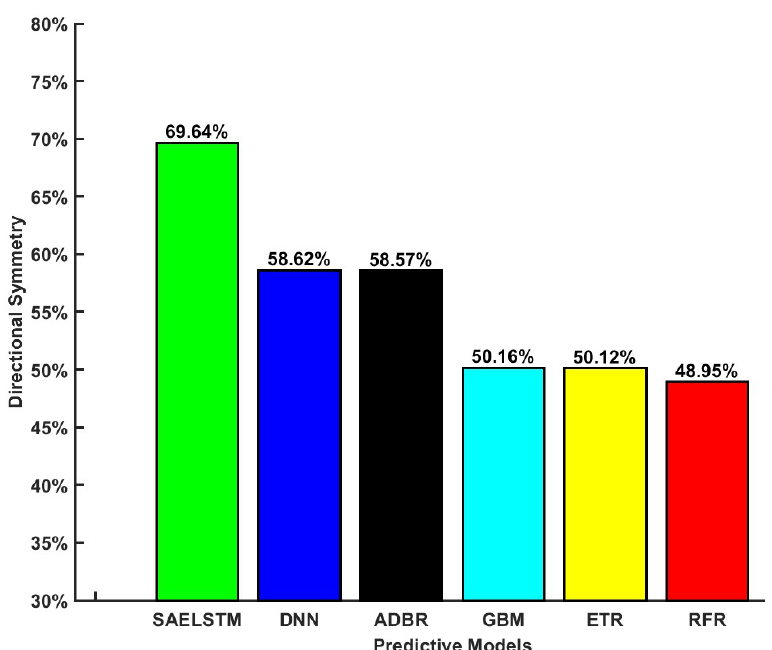
Figure 11. The performance of the proposed SAELSTM model compared to other counterpart models under study in terms of directional symmetry (DS) criteria. (Note: Names for each model are provided in Tables 3 and A1 in the Appendix A.)